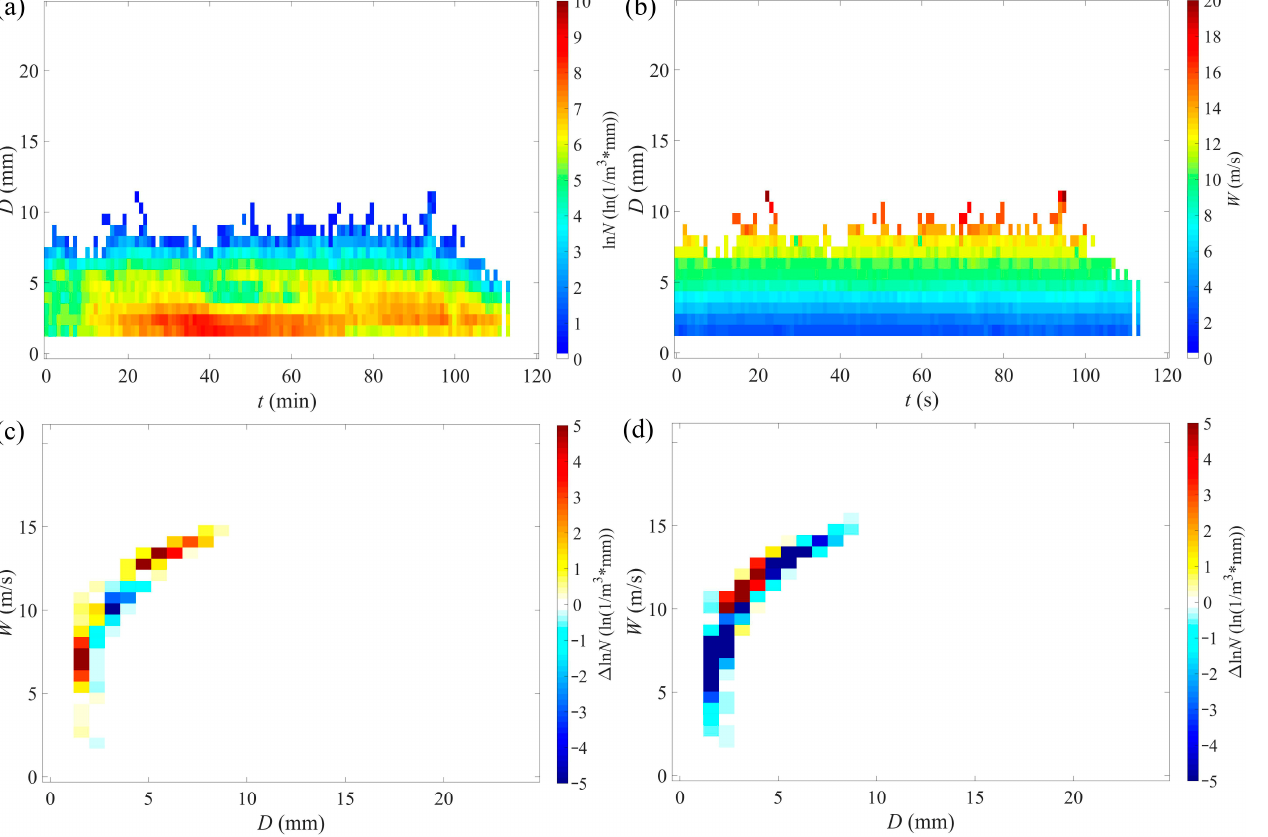
Figure 11. Temporal evolution of raindrop size distributions measured by OTT at the field site. ( a ) Concentration; ( b ) velocity; ( c ) W – D relationship under interference and natural conditions; ( d ) W – D relationship when turning the device on and off.